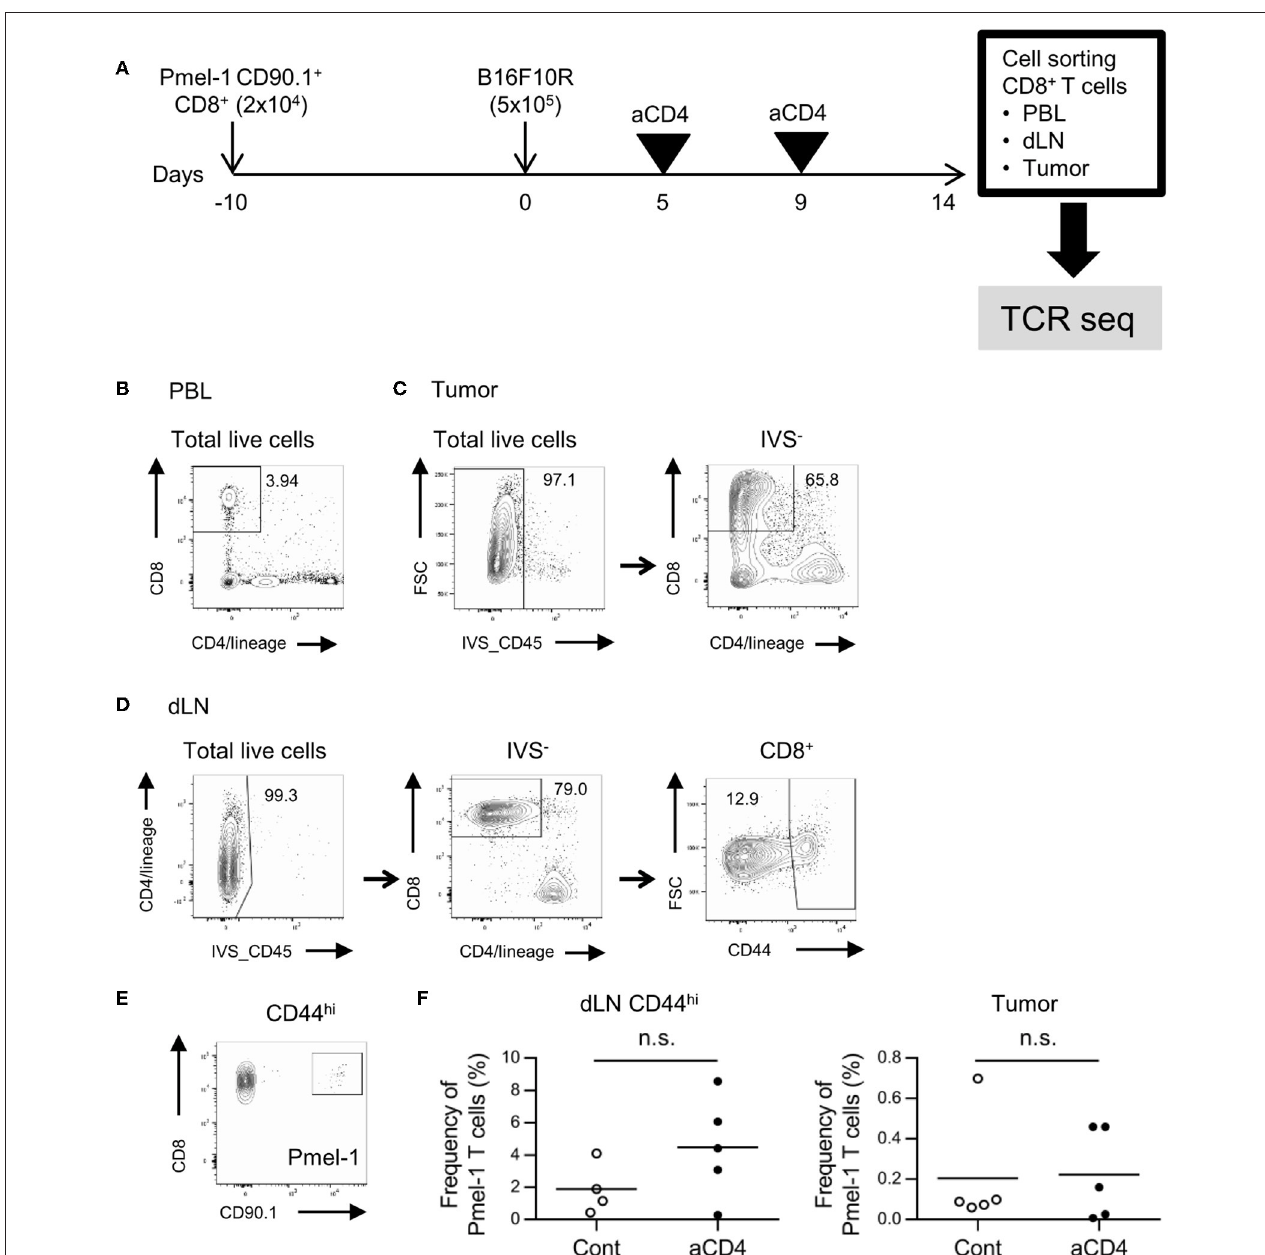
FIGURE 1 | Gating strategy for CD8 + T cells in the dLN, PBL, and tumor. (A) Experimental procedure. Melanoma antigen-specific TCR (TCRV α 1V β 13; Pmel-1) expressing CD8 + T cells with the CD90.1 congenic marker was adoptively transferred 10 days prior to B16F10 tumor inoculation into C57BL/6 mice (CD90.2). Tumor-bearing mice were injected i.p. with anti-CD4 mAb on days 5 and 9, and CD8 + T cells in the dLN, PBL, and tumor were isolated using cell sorters. (B–D) Flow cytometry plots showing CD8 + T cells in the PBL (B) , tumor (C), and dLN CD44 hi population (D) . Numbers in flow-cytometry plots indicate frequencies within parental populations (B–D) . A similar gating strategy was used for CD8 + T cell isolation using cell sorters. (E) Flow cytometry plots showing the CD8 + Pmel-1T cells in the dLN. A similar gating strategy was used in PBL and tumor. (F) Frequency of Pmel-1T cells in dLN CD44 hi (left) and tumor (right) by flow cytometry. Two-sided unpaired Student’s t -tests ( n = 5, except for dLN CD44 hi of aCD4: n = 4).